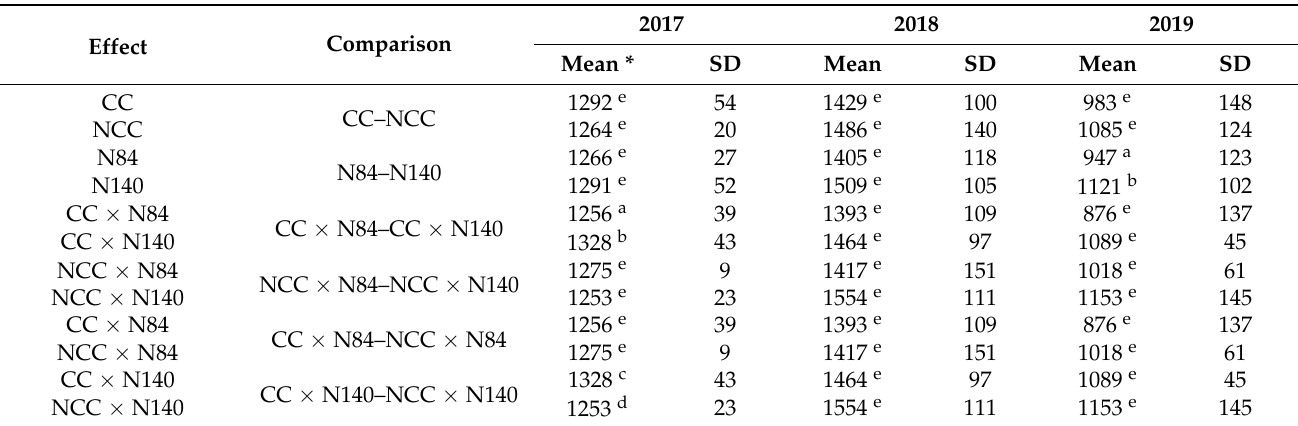
Table 2. Lint yield means (kg ha − 1 ) and mean comparison of various